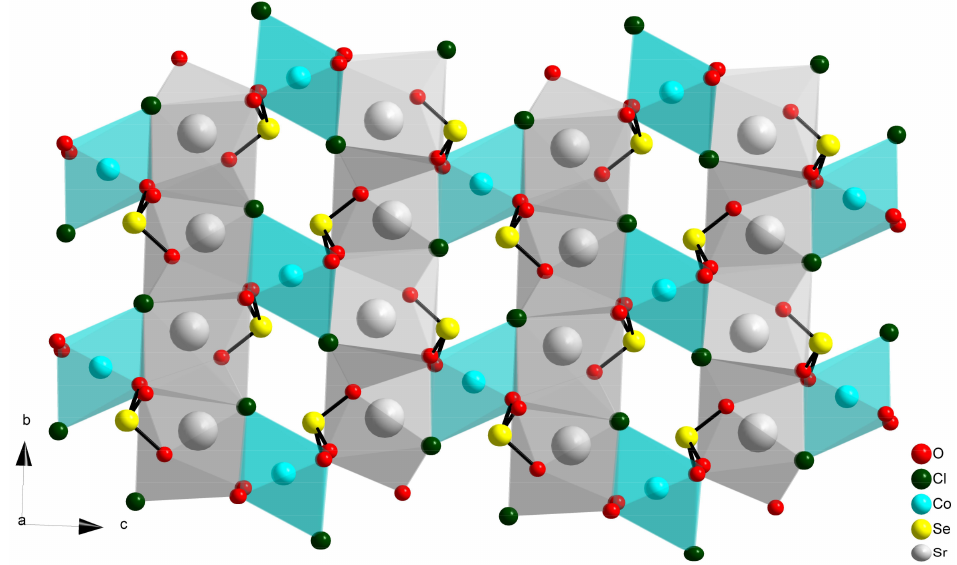
Figure 3. Layers of [SrO 6 Cl 3 ] polyhedral connected by [MO 4 Cl 2 ] octahedra and SeO 32– groups in the crystal structure of Sr 2 Co(SeO 3 ) 2 Cl 2 [26].